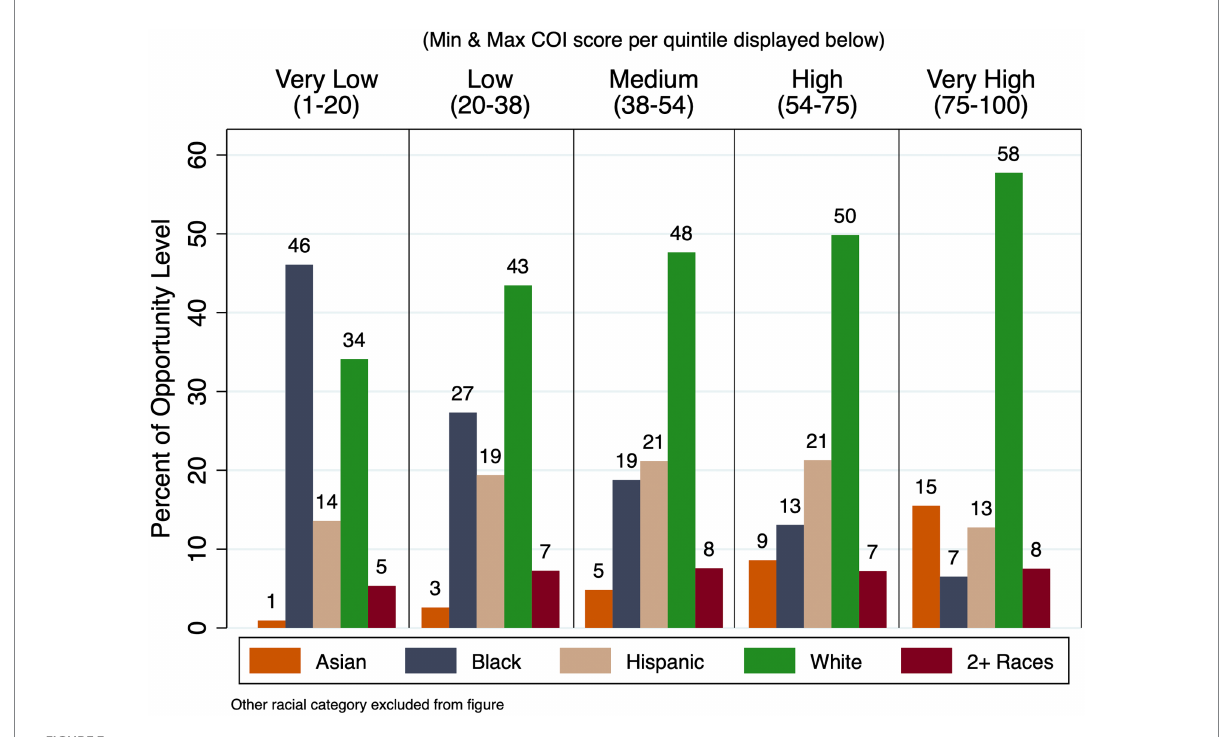
FIGURE 3 Share of observed students by race/ethnicity and COI